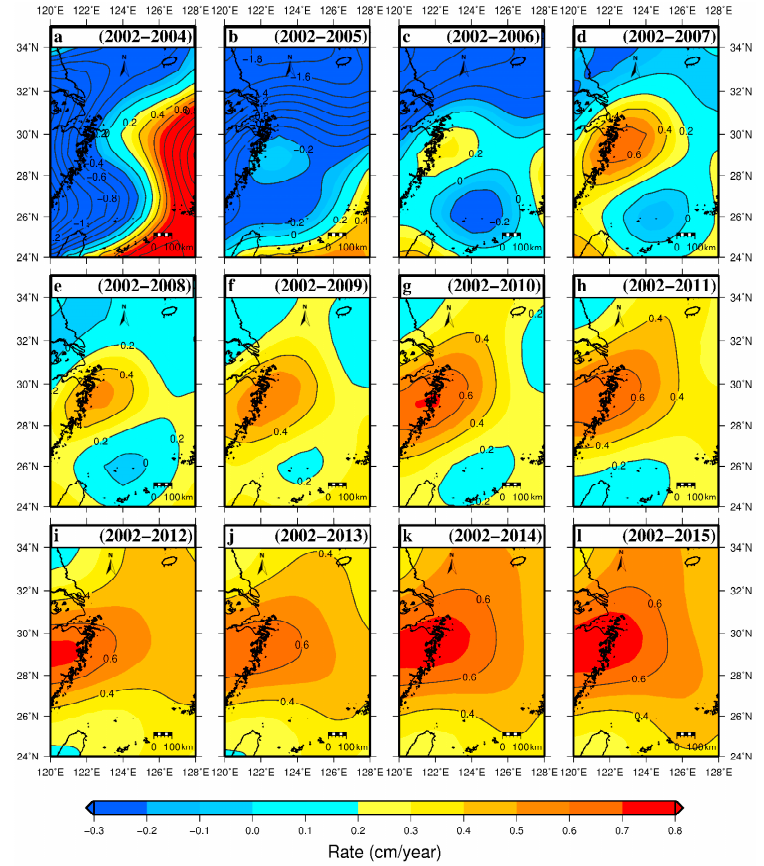
Figure 9. ( a – l ) Different spatial patterns of EWH rates on the ECS inner shelf using GRACE records spanning different time